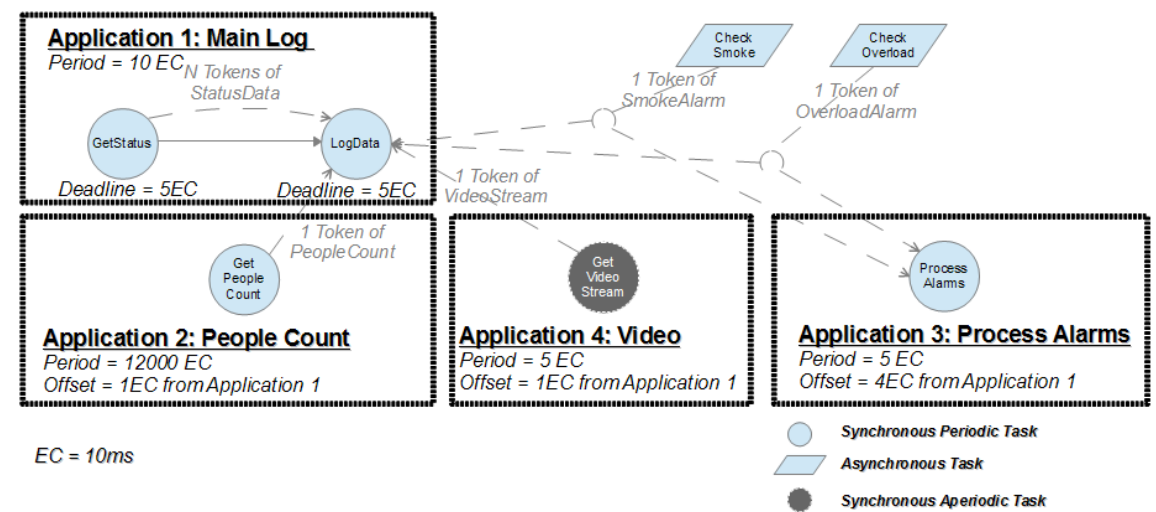
Figure 8. Graphs of the TCN